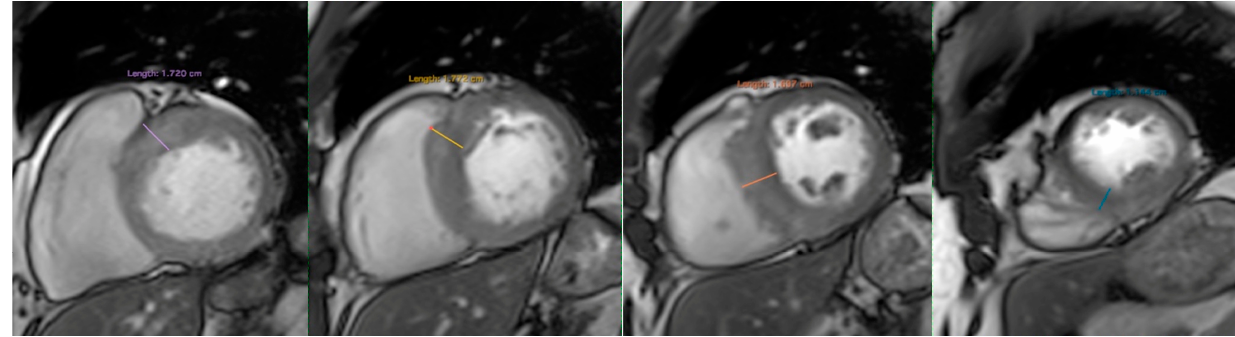
Figure 2. LV wall thickness measurement on CMR.